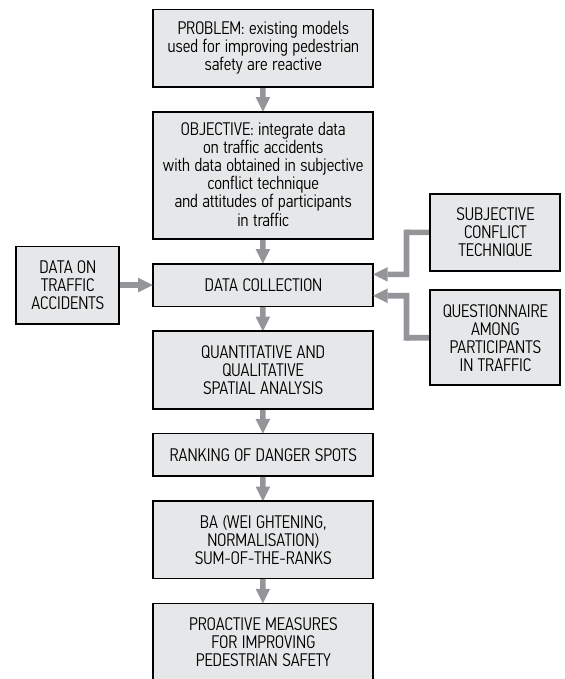
Fig. 2. The algorithm of methods for detecting and ranking danger spots for